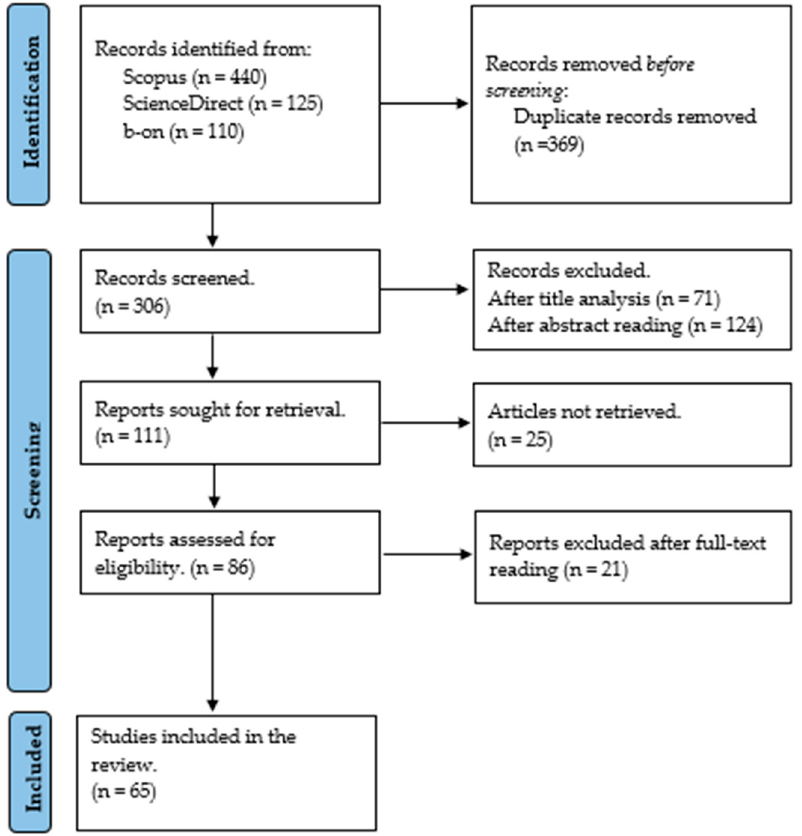
Figure 1. Number of papers at each level of the systematic review process (PRISMA diagram).